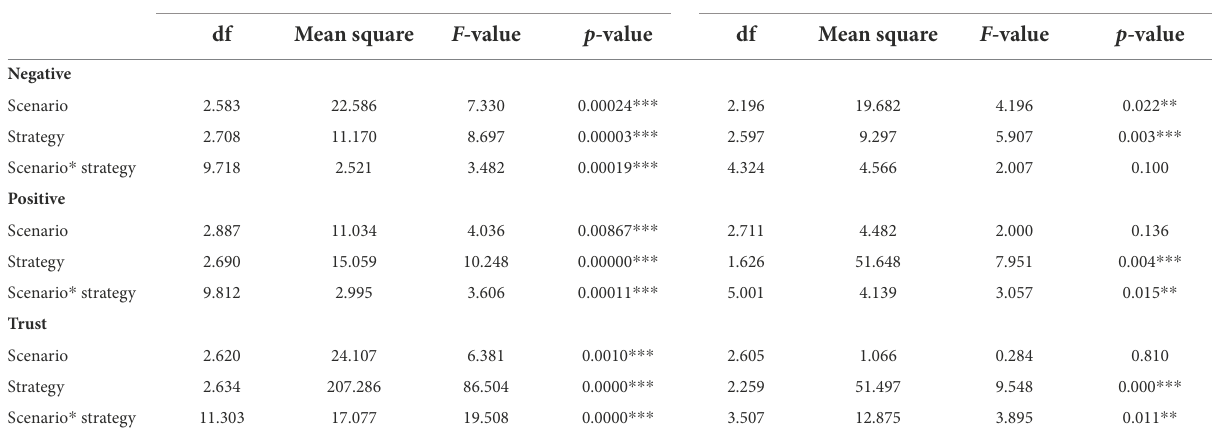
TABLE 5 Factors contributing to negative, positive, and